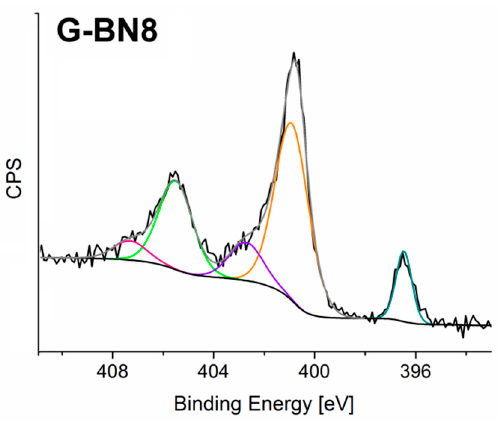
Figure 10. Partial XPS spectra of the N1s and Sc2p regions for G-BN8